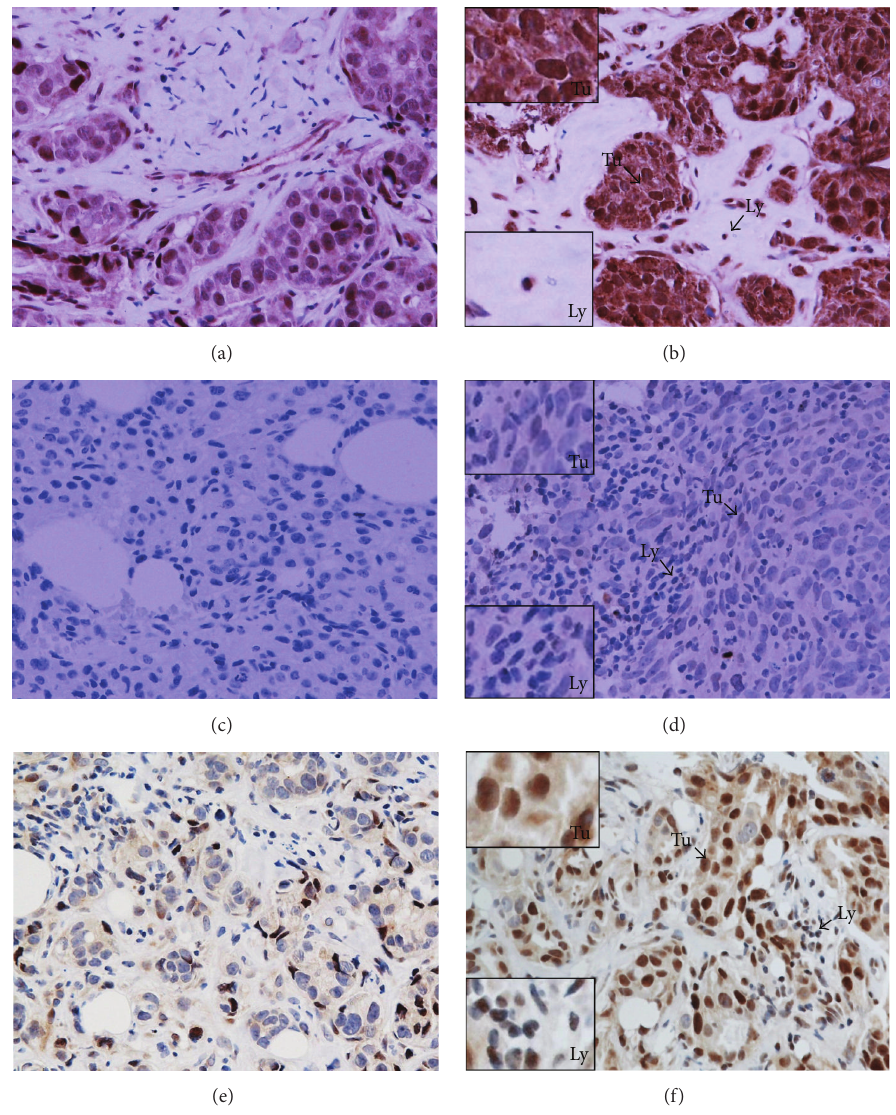
Figure 7: IL-17 (a, b), TGF- 𝛽 (c, d), and PD-L1 (e, f) expression in the sections of LLABCs, using IHC staining, at 400x magnification. Briefly, heat-mediated antigen retrieval was performed using citrate buffer, pH 6 (20 mins). The sections were then incubated with polyclonal Abs to IL-17 (Abcam, ab9565) at a 1:100 dilution for 30 mins at RT, MAbs to TGF- 𝛽 (Abcam, ab64715) at a concentration of 12 𝜇 g/mL overnight at 4 ∘ C, and polyclonal Abs to PDL1 (Abcam, ab58810) at a concentration of 2.5 𝜇 g/mL for 15 mins at RT, respectively. Polymeric HRP-linker antibody conjugate was used as secondary antibody. DAB chromogen was used to visualize the staining. The sections were counterstained with haematoxylin. (a, c, e) Low level of expression; (b, d, f) high level of expression. The 𝐻 score (% of positive cells (brown membrane/cytoplasmic-stained tumour and immune cells) × intensity of staining (1 to 3)) was used to assess the level of expression; low was ≤ 100 and high was > 100. Scoring performed on whole tissue section ( > 10 HPFs); Tu: tumour and Ly: